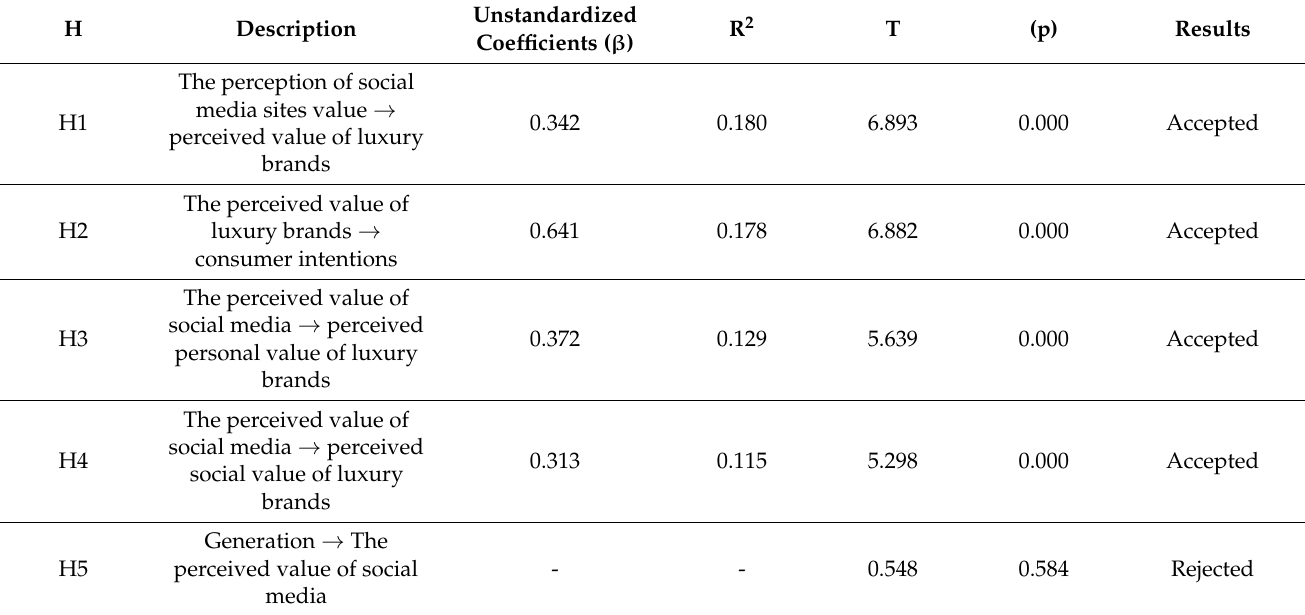
Table 2. Synopsis of empirical results regarding the research